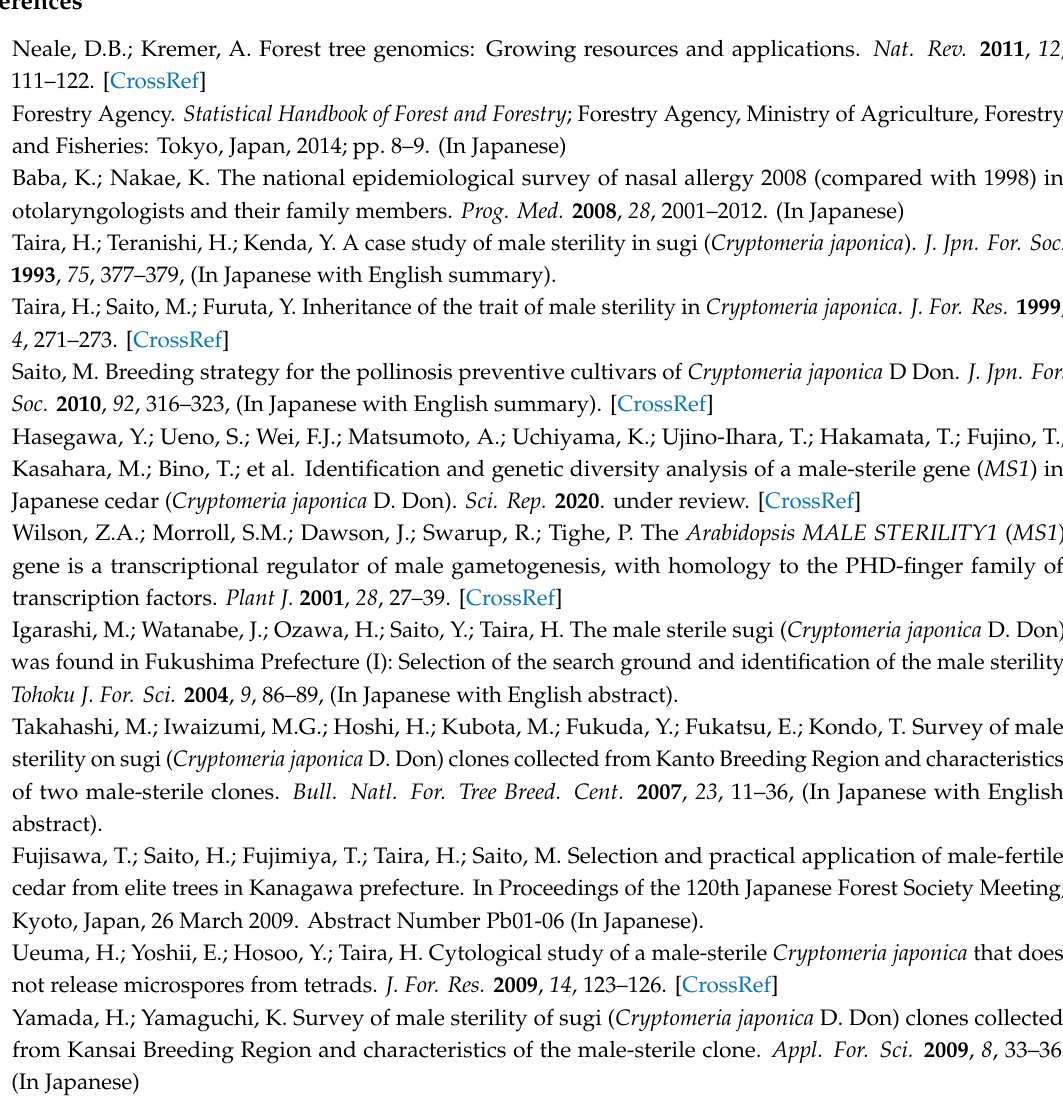
Table S1: Primer sequence of the SNaPshot assay, Table S2: Primer sequence for a 48.48 Dynamic Array, Table S3: Cost comparison of ASP and ALP markers by means of agarose gel and the fragment analysis using a sequencer in marker-assisted selection (MAS) of 96